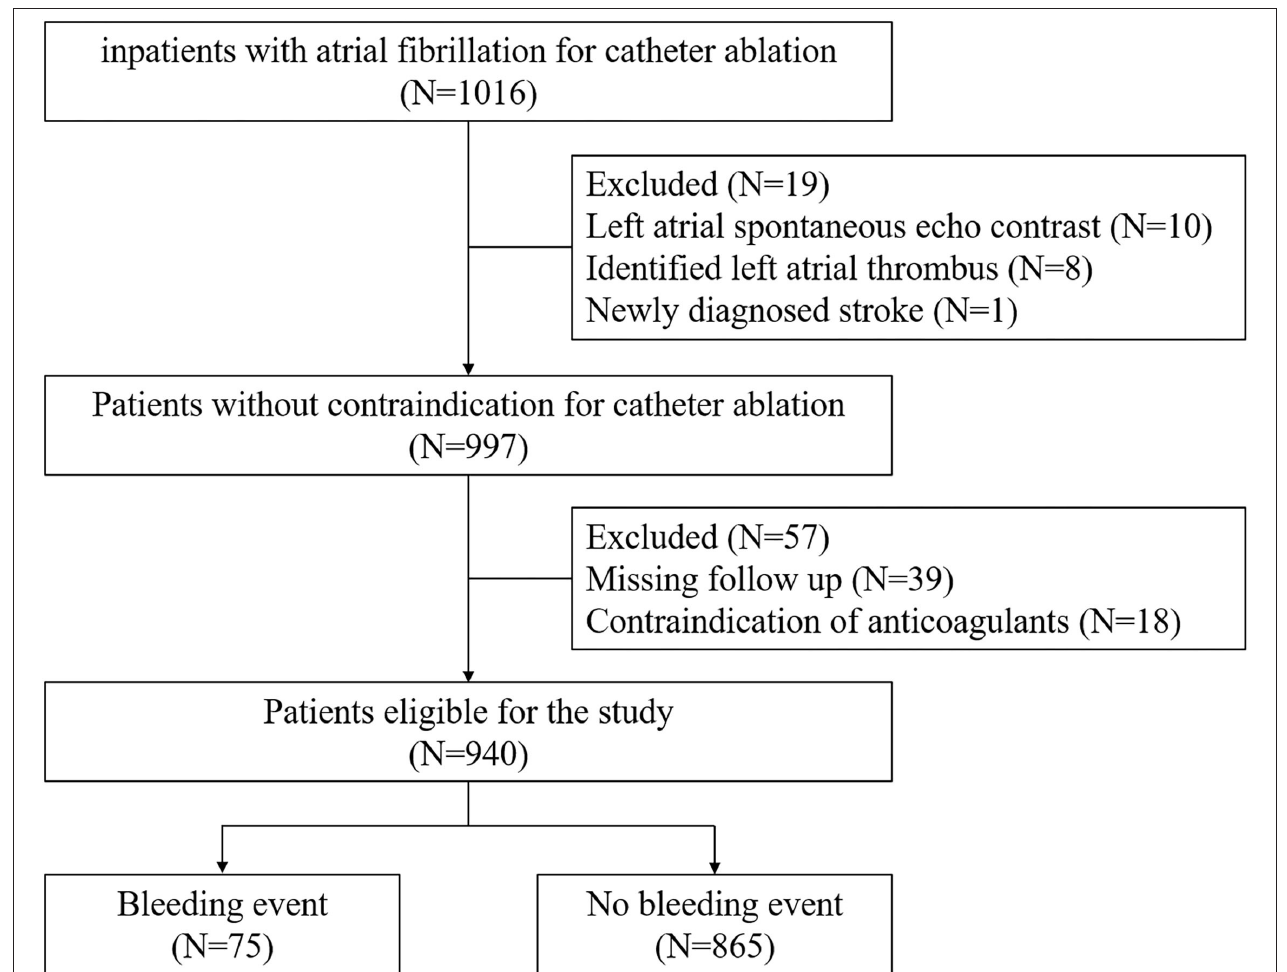
FIGURE 1 | Patient flow